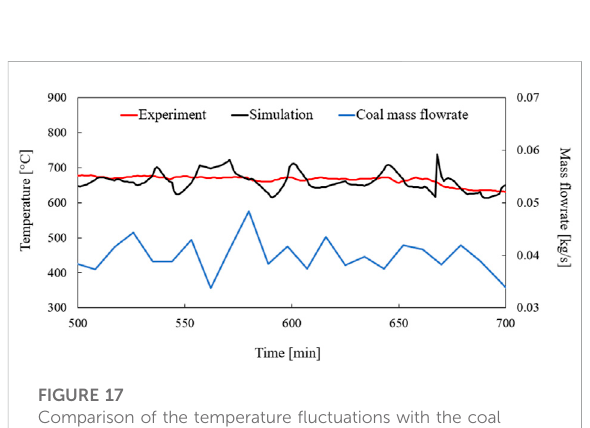
FIGURE 17 Comparison of the temperature fl uctuations with the coal stream.